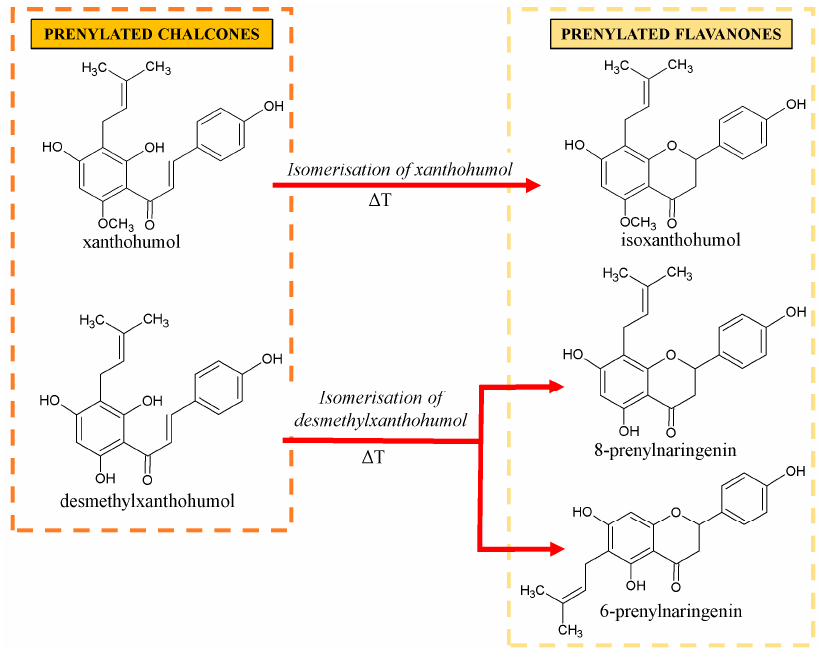
Figure 1 . Prenylated flavonoids from hops. Figure 1. Prenylated flavonoids from